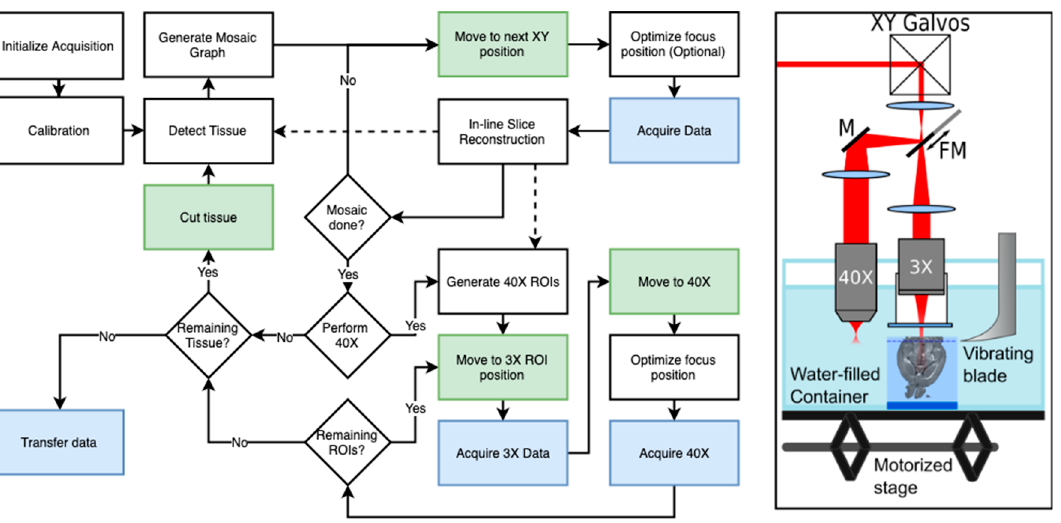
Figure 2. A representation of a fully automated dual-resolution serial OCT imaging system (Right) and a diagram of the workflow pipeline used to control the acquisition (Left): The 2R-SOCT consists in a vibratome coupled to two OCT arms, a 3X arm to acquire low-resolution data (25 µ m / voxel) used for the whole mouse brain reconstruction, and a 40X arm used to acquire high-resolution images (1.5 µ m / voxel) in automatically chosen regions of interests (ROIs). The solid lines represent the order of operation of acquisition. The dashed lines represent data transfer to other parts of the workflow (e.g., sending in situ assembled slices to generate 40X ROIs). The green shaded boxes are tasks necessitating mechanical movements, and the blue shaded boxes represent data generation or transfer operations. FM: Flip mirror, M: Mirror. Adapted from our previous work